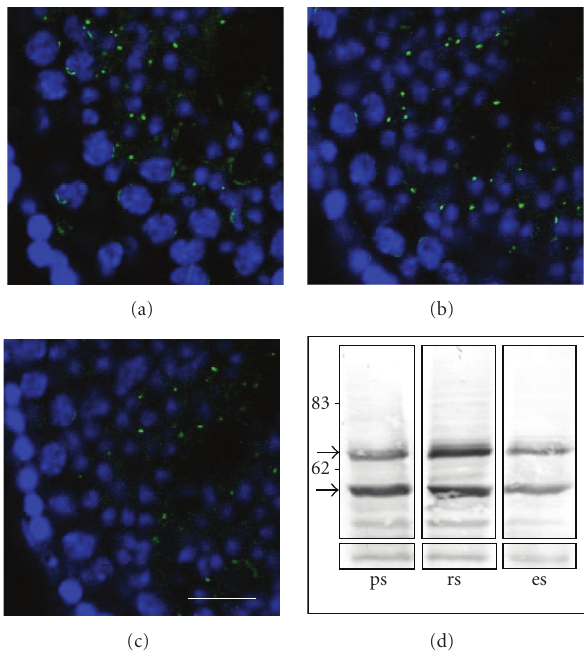
Figure 1: Distribution of RFP isoforms in meiotic and postmeiotic germ cells. (a)–(c) Immunofluorescent labeling of RFP on testis sections corresponding to late VIII and IX stages of mouse spermatogenesis. Sequential optical layers are separated by 4 μ m from each other. RFP positive signals (green) are detected either as a cap-like structure localized at the border of the nucleus (DAPI, blue) in pachytene spermatocyte (mainly seen in (a)) or as a dot in post meiotic germ cells and in residual bodies (mainly seen in (b) and (c)). Scale bar, 25 μ m. (d) 20 μ g of proteins prepared from 80%– 90% pure elutriated preparations of pachytene spermatocytes (ps), round spermatids (rs), and elongated spermatids (es) were analyzed by western blotting with rabbit anti-RFP polyclonal antibody. Sizes (kDa) are indicated on the left side and the two RFP isoforms (58 and 68 kDa) are indicated by the arrows. A nonrelevant band was used as loading control (lower part).